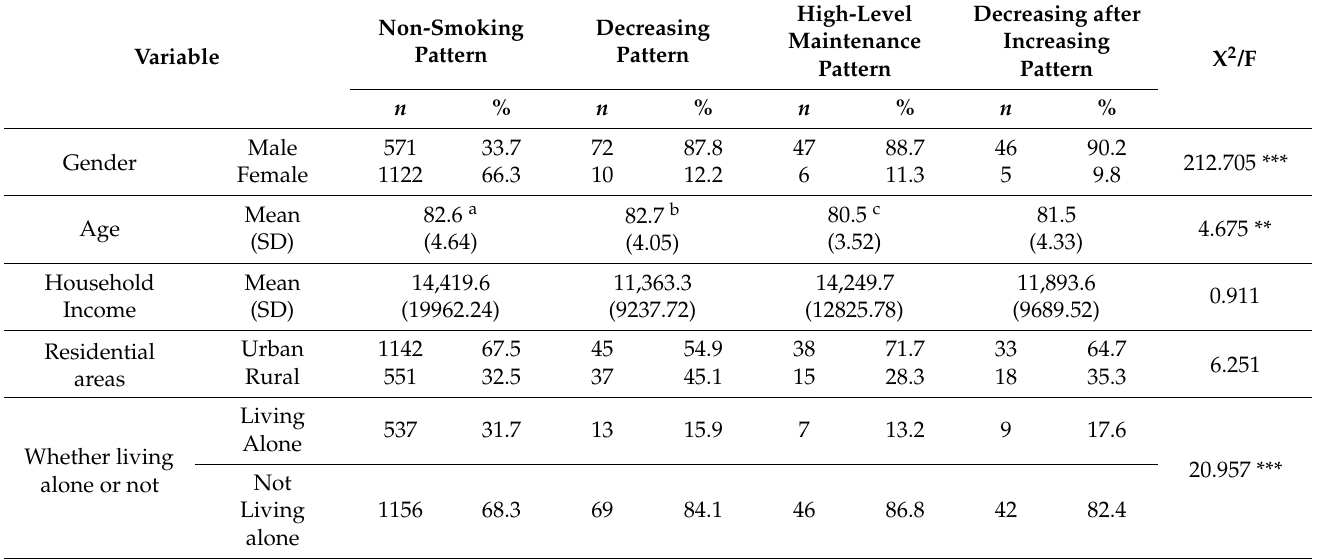
Table 4. Differences of Patterns of Older Adults’ Smoking Behavior Changes ( n =